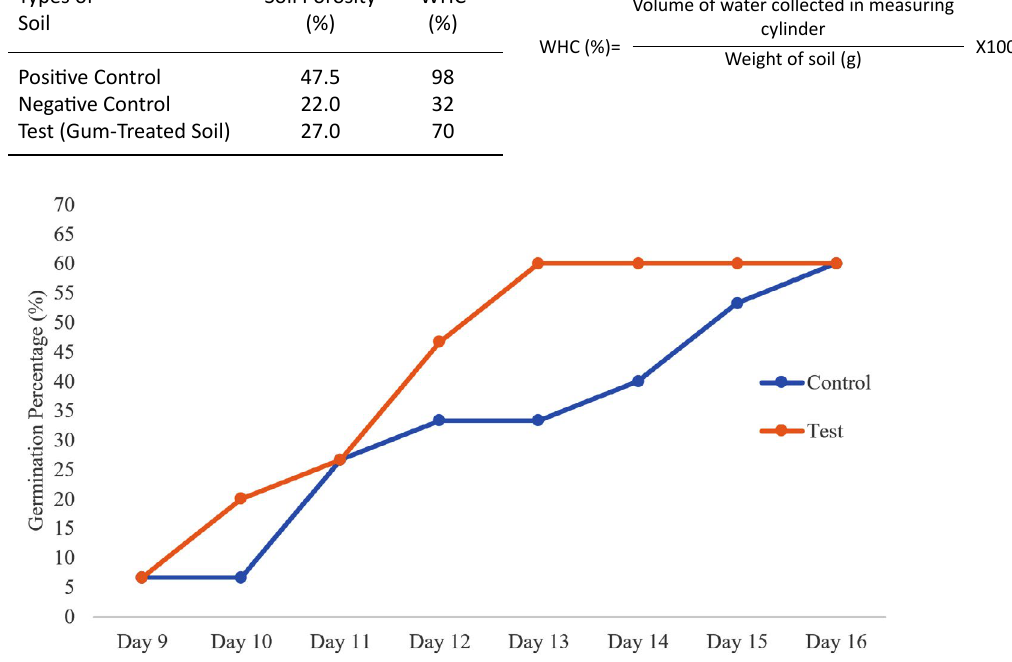
Table 3. Soil porosity of the three different types of soil: positive control, negative control and test Types of